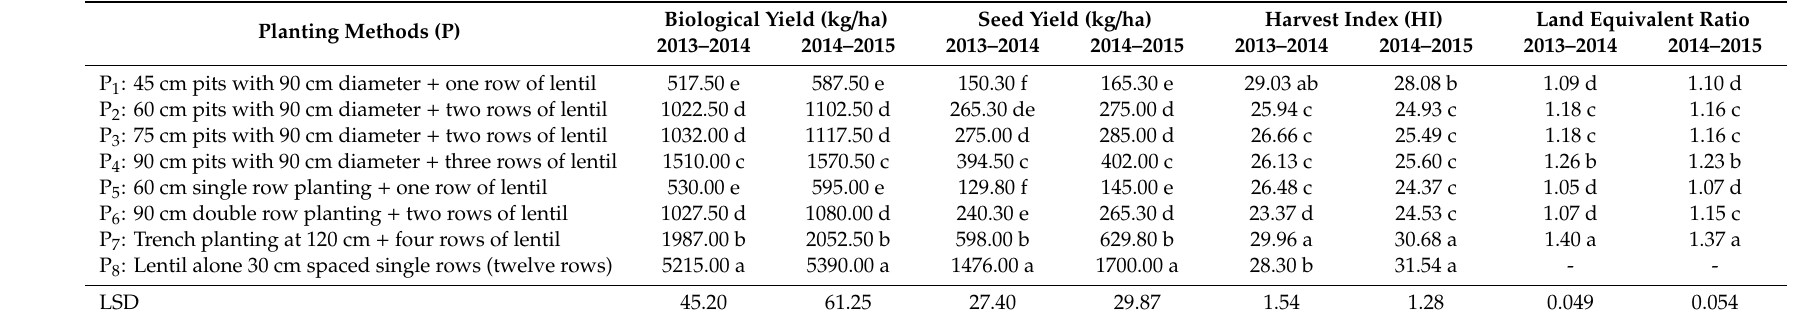
Table 4. Yields, harvest index of lentil, and land equivalent ratio under di ff erent planting patterns with lentil intercropping. Planting Methods